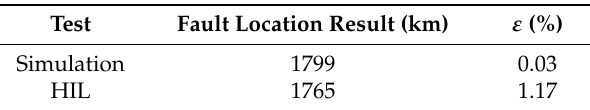
Table 8. Location estimation of ABC fault.